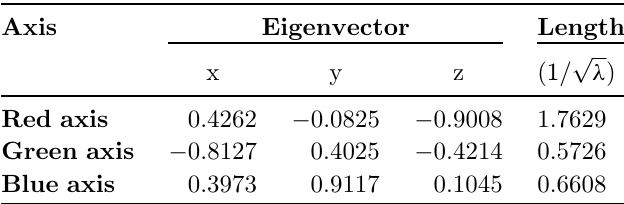
Table 4. Parameters of the ellipsoid resulting from the planning of the 4th trajectory with duration 0.55 s, expressed with respect to the tool frame.